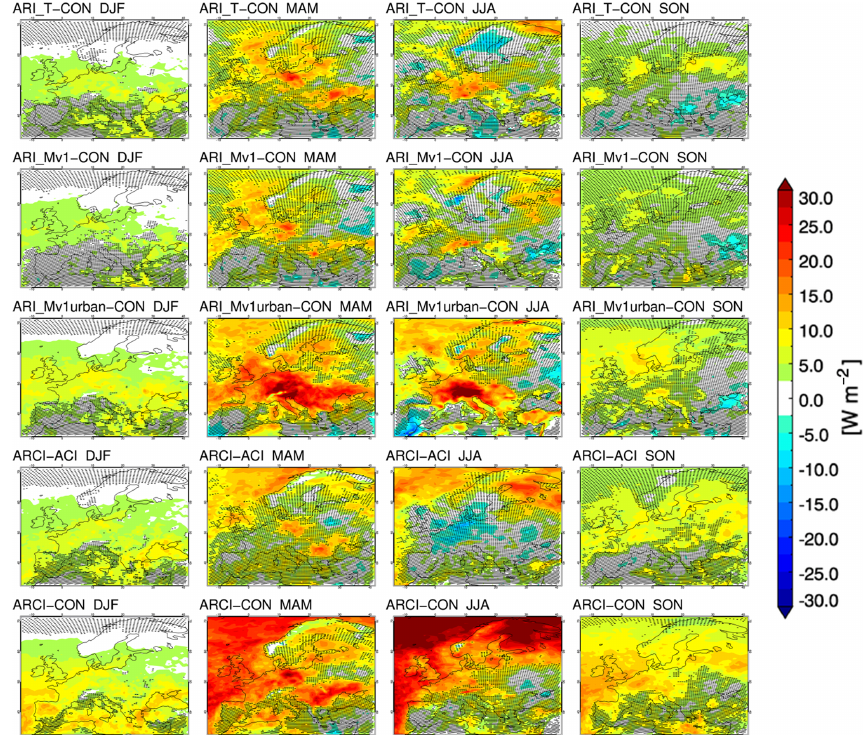
Figure 7. Shortwave cloud radiative effect difference ( (cid:49) SCRE) for all seasons. Rows 1–3: for selected ARI group simulations (ARI_T, ARI_Mv1, ARI_Mv1urban) that implement only aerosol–radiation interactions. The (cid:49) SCRE has been calculated as the difference of cloud radiative effect (SCRE) from control CON and depicts the impact of aerosol–radiation interactions only. The fourth row depicts the aerosol– radiation interactions in an environment where the indirect effect is also present and displays the difference of experiment ARCI to ACI. The bottom row depicts the impact of aerosol–radiation interactions plus the impact of the TE2014 microphysics scheme with aerosol–cloud interactions. It displays the difference of experiment ARCI to CON. Stippling indicates areas where the differences are not statistically significant at the 95% level, according to the Mann–Whitney non-parametric